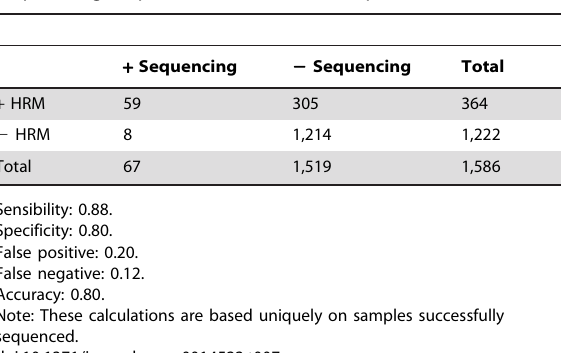
Table 7. Comparison between HRM mutation screening and sequencing of paraffin-embedded